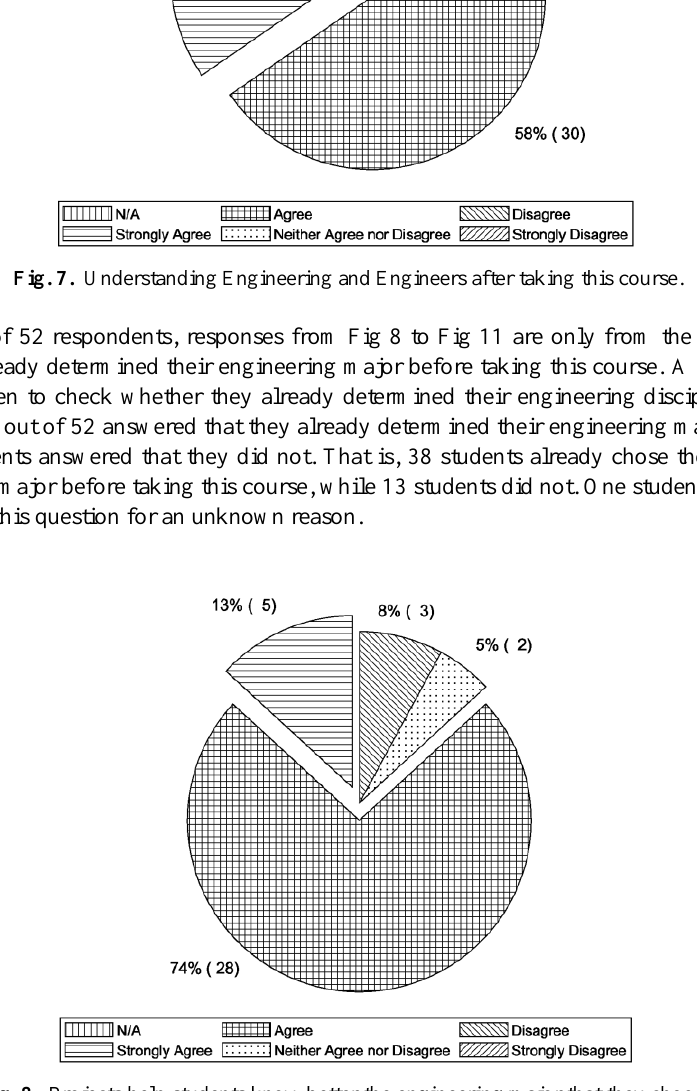
Fig. 8. Projects help students know better the engineering major that they